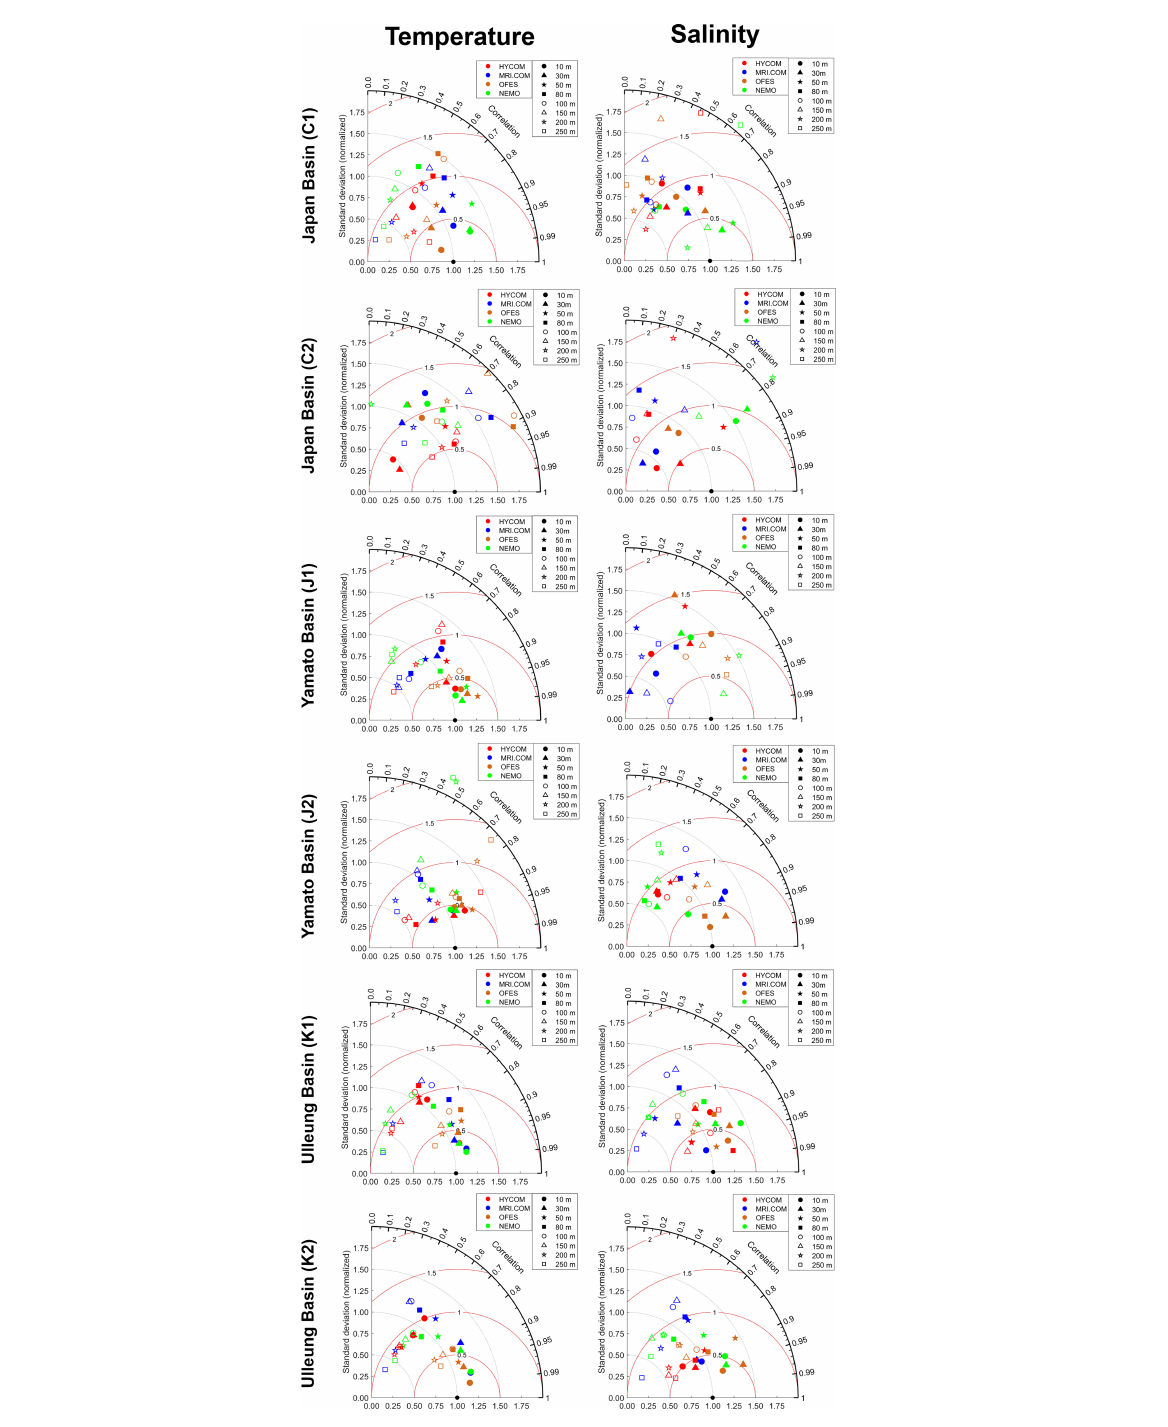
FIGURE 3 Taylor diagrams plotted from monthly time series of temperature (left) and salinity (right) from 1993 to 2014 at standard depths at the monitoring station C1 and C2 in the Japan Basin, J1 and J2 in the Yamato Basin, and K1 and K2 in the Ulleung Basin. Correlation, normalized standard deviation, and centered RMS difference of the simulated time series from the ocean models HYCOM (red) and NEMO (green), MRI.COM (orange), and OFES (blue) compared with the observational data are shown. Different markers refer to different standard depths. See text for more